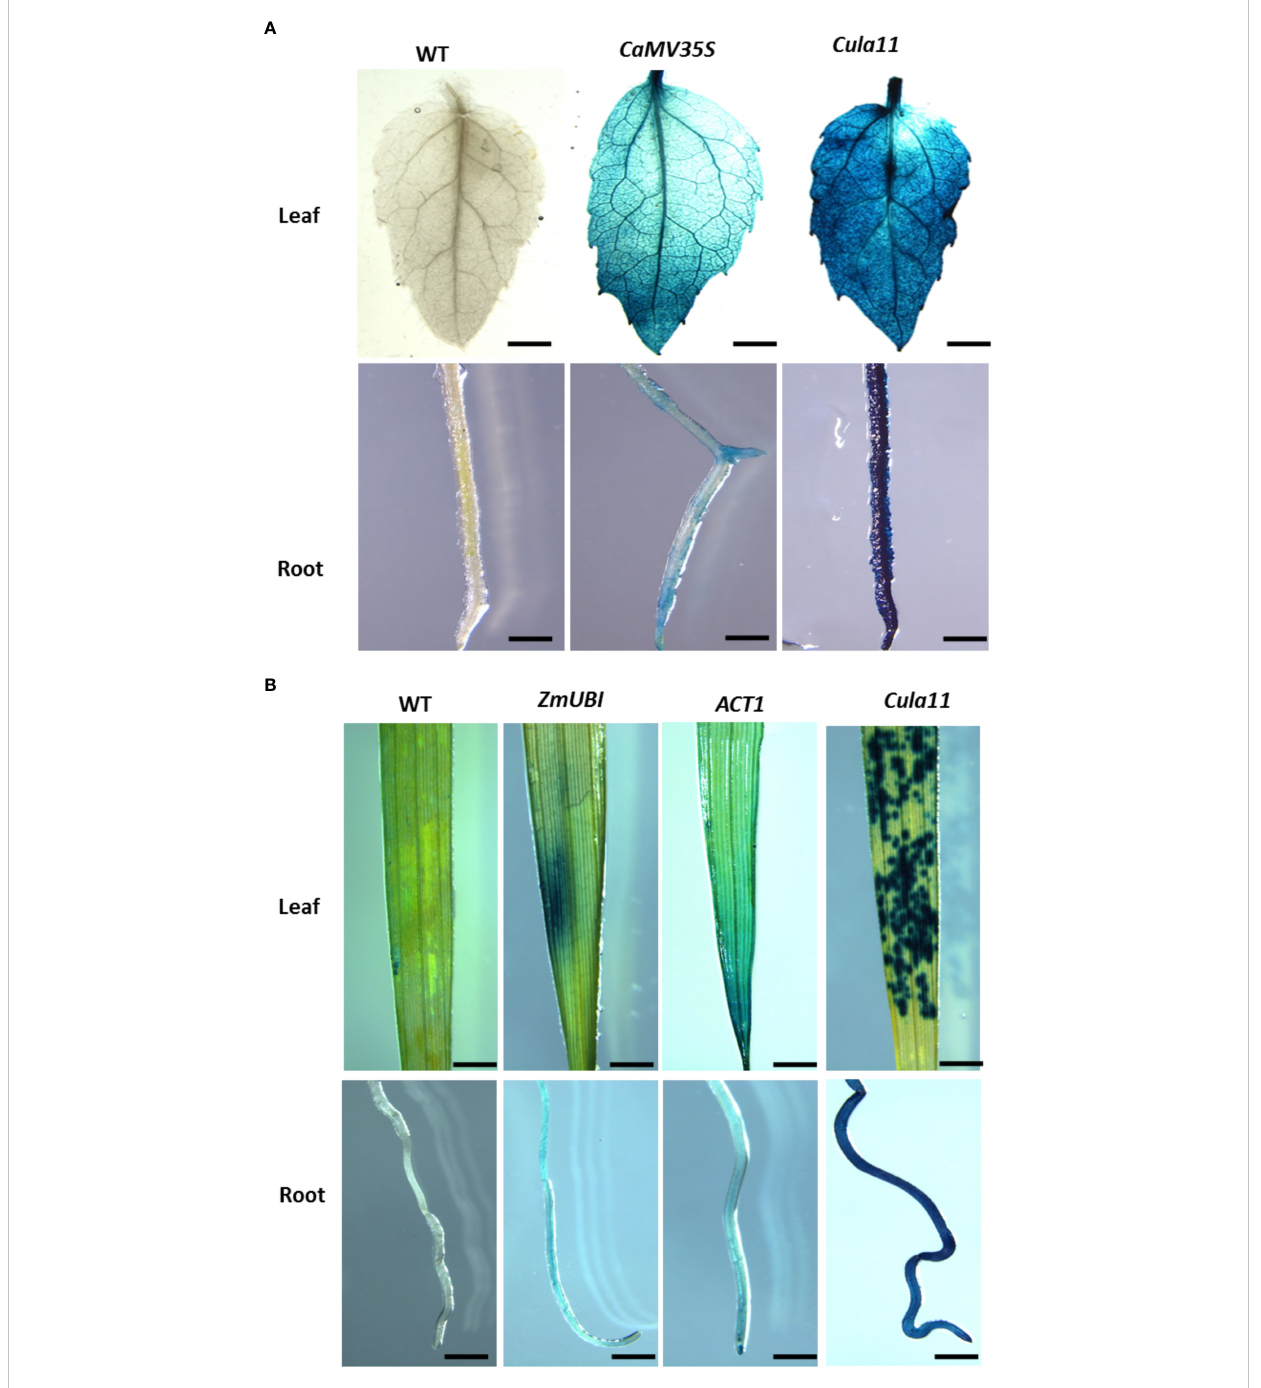
FIGURE 4 Cula11 promoter activity assay in the root and shoot of the promoter:GUS transgenic poplars and rice. (A) Transgenic poplars harboring the Cula11 promoter:GUS were analyzed in comparison with the transgenic lines containing 35S:GUS constructs. Roots (UP panel) and shoots (Bottom Panel) from at least 3 independent transgenic lines were analyzed, and represented images were shown here. Scale bar: 2 cm; (B) Transgenic rice harboring Cula11 promoter:GUS were analyzed in comparison with the transgenic lines driven by ZmUbi : GUS and Act1:GUS . Roots (UP panel) and shoots (Bottom Panel) from at least 3 independent transgenic lines were analyzed, and represented images were shown here. Scale bar: 1